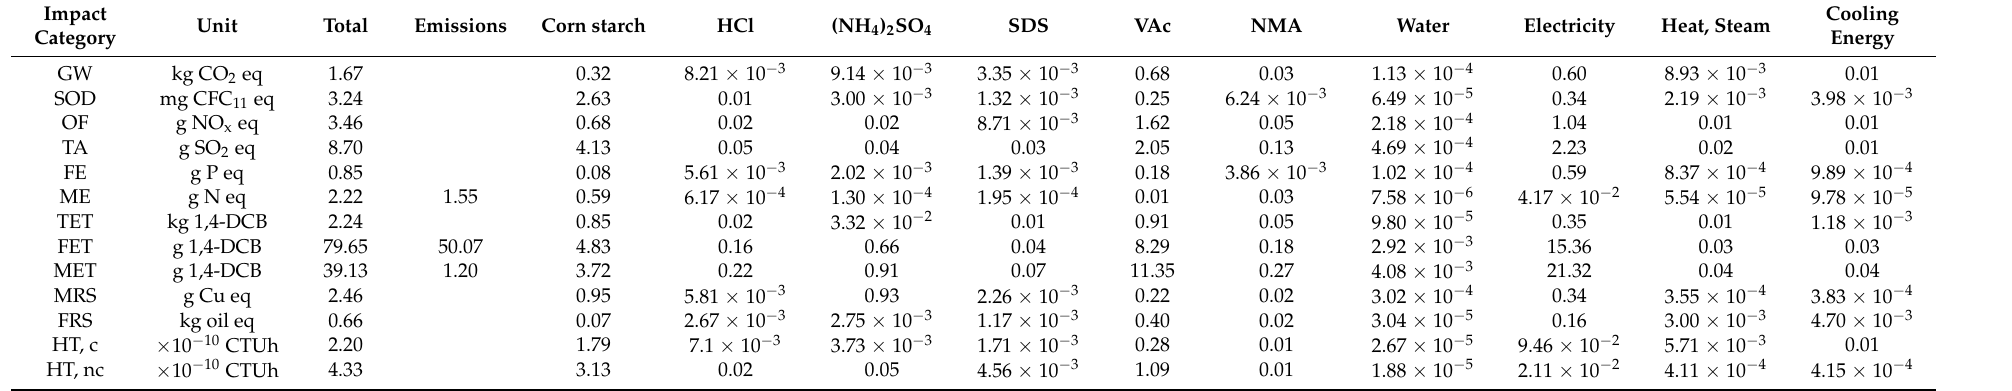
Table 7. Environmental characterization of hydrolyzed starch bioadhesive with N-methylol